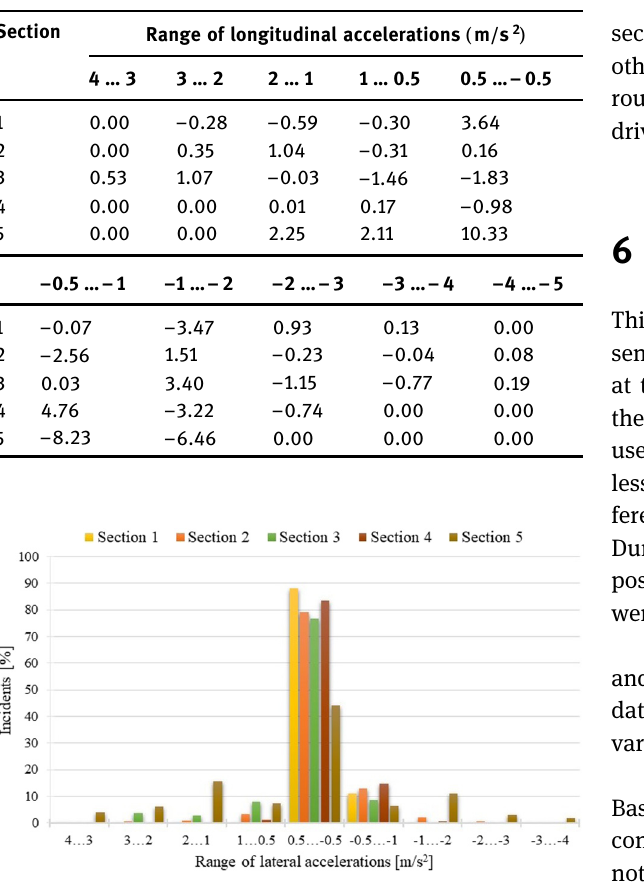
Figure 16: The frequency of occurrence of particular values of lateral acceleration for selected sections of the route – morning drive.